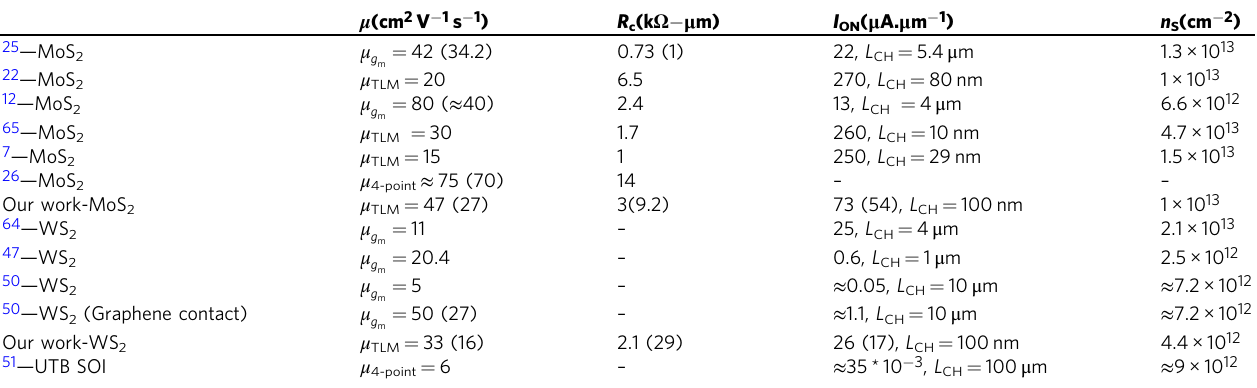
Table 3 Benchmarking ON-state performance at V DS = 1 V (best values are compared with median/mean values shown within